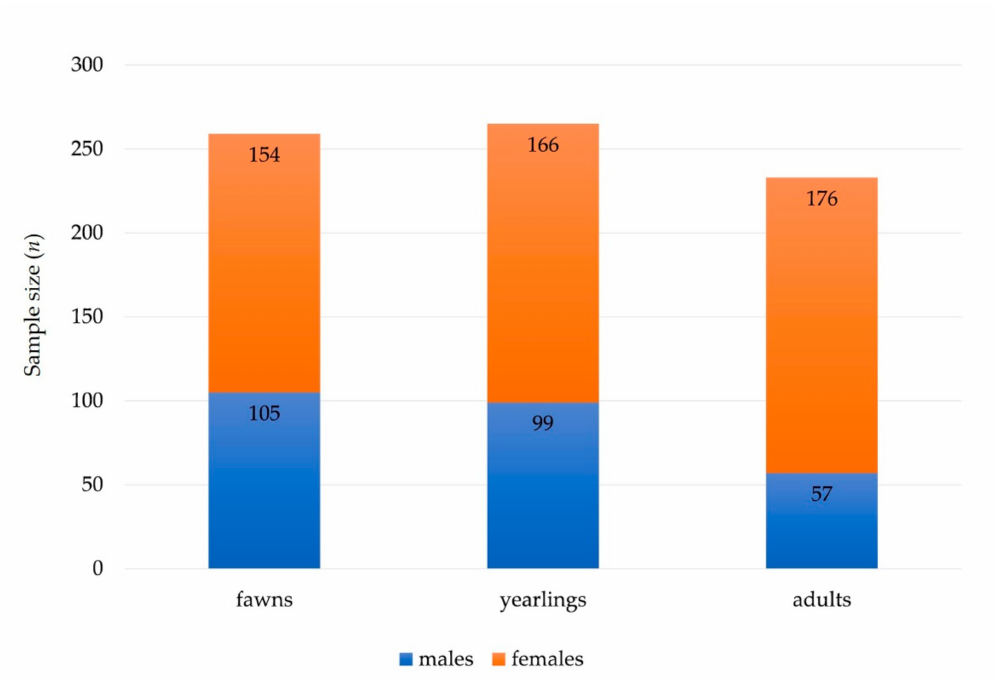
Figure 1. Summary of sex (males and females) and age (fawns, yearlings, and adults) structure of free ranging roe deer sampled and analyzed for diseases.